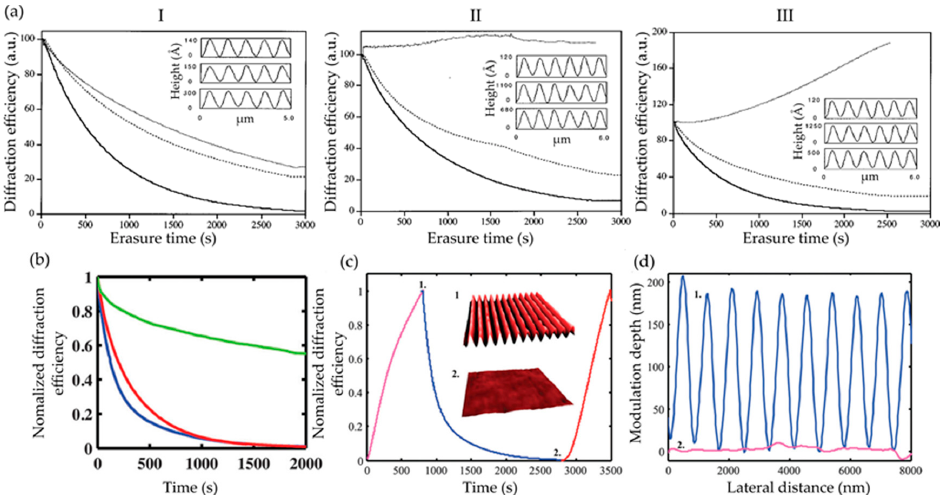
Figure 7. ( a ) The erasure behavior of SRGs under three erasing polarization conditions (parallel (solid) and perpendicular (dotted) polarized to the grating’s grooves and circular (dashed) polarized light) with different writing conditions (I: p-p, II: s-s, III: circular polarized). Reproduced from [87]; ( b ) The erasure behavior of SRGs expressed as normalized diffraction efficiency for samples with molecular weights of 1000 (blue), 3200 (red) and 7000 (green) g mol − 1 ; ( c ) Normalized diffraction efficiency of the SRG inscription (magenta), erasure (blue) and rewriting (red) of 1000 g mol − 1 azo-containing polymer. Insets show 3D AFM images of the inscribed (1) and erased SRG (2), with AFM surface profiles of these states shown in ( d ). Reproduced from [90].